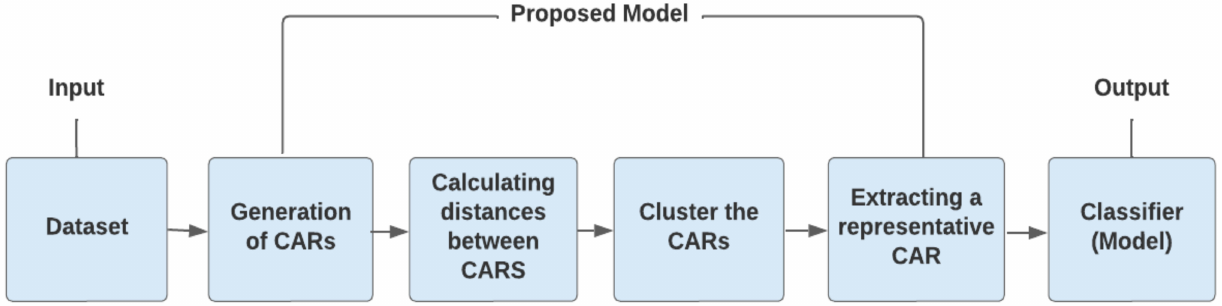
Figure 1. Overview of the developed associative classification